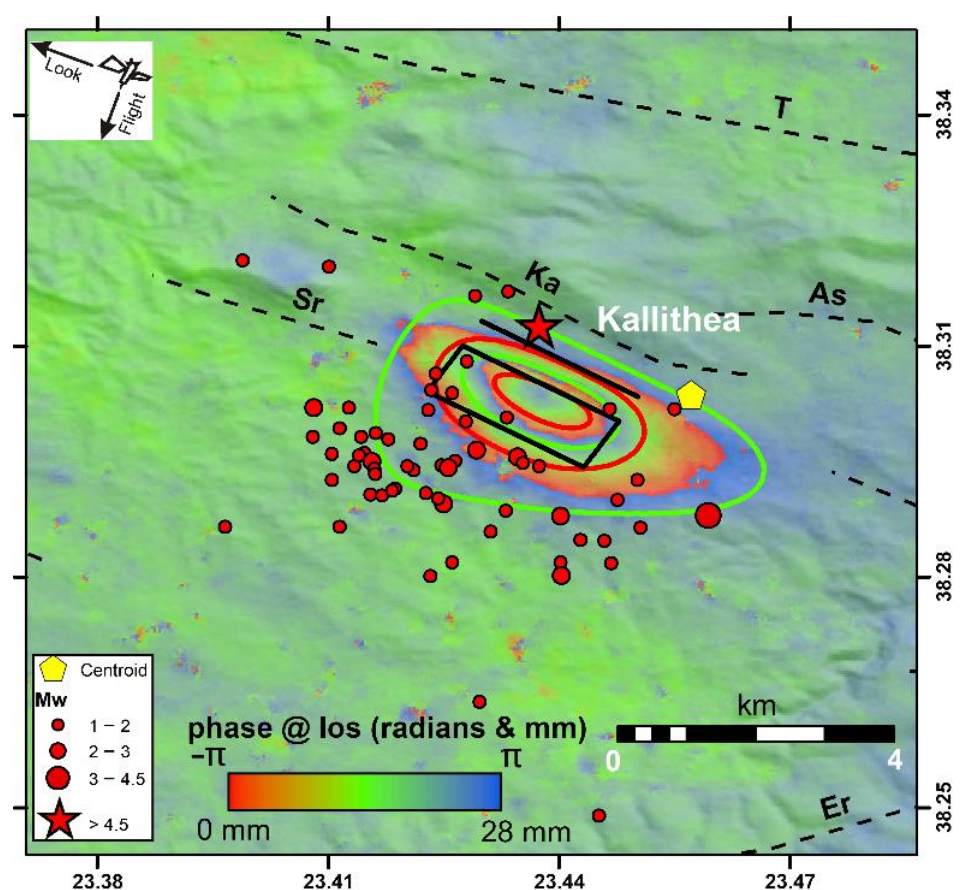
Figure A4. The descending interferogram of track 7, spanning the dates 21 November 2020–3 December 2020, and the model in contour lines every half fringe (14 mm) with the same color coding are shown. Notation as in Figure 6.